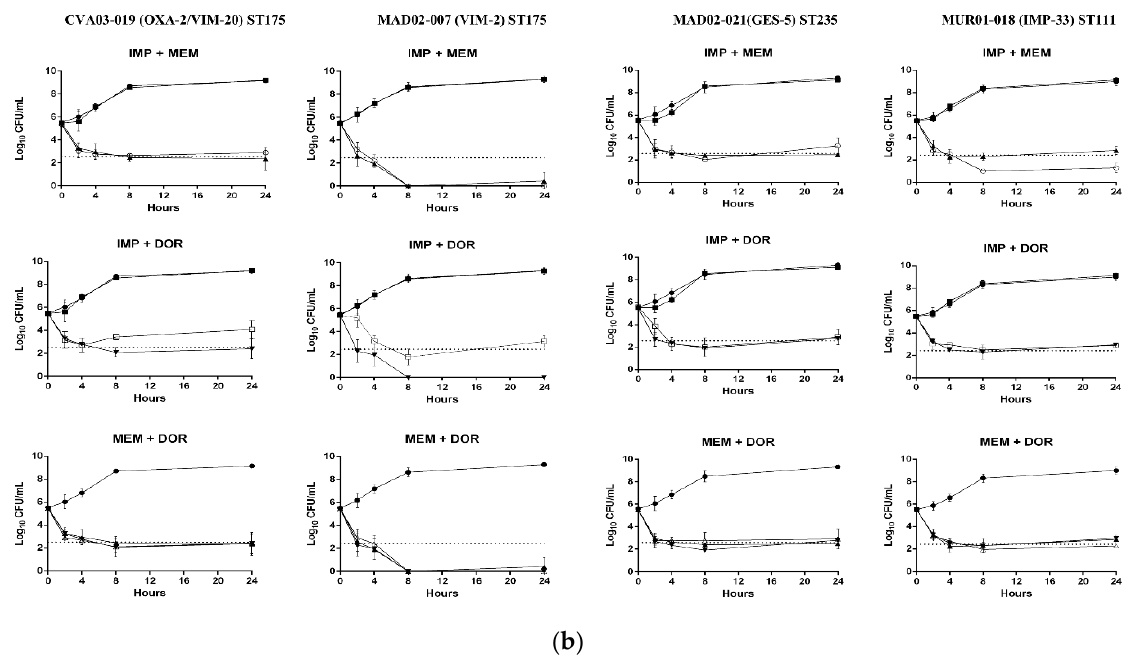
Figure 2. ( a ) Time-kill assays for imipenem, meropenem, and doripenem alone and in combination at maximum mice plasma concentration (Cmax) against the four isolates of carbapenemase-producing P. aeruginosa selected for in vivo studies. Results are represented as differences (log 10 CFU/mL) relative to the initial time point (0 h). Green indicates a >3 log 10 CFU/mL decrease, yellow a < 3 log 10 CFU/mL decrease. ( b ) Time-kill assays for imipenem, meropenem, and doripenem alone and in combination at maximum mice plasma concentration (Cmax) against the four of carbapenemase-producing P. aeruginosa isolates selected for in vivo studies. Solid circle: growth control; Square: imipenem (IMP); Triangle: meropenem (MEM); Inverted triangle: doripenem (DOR); Empty circle: IMP + MEM; Empty square: IMP + DOR; Empty triangle: MEM + DOR; Dotted line: